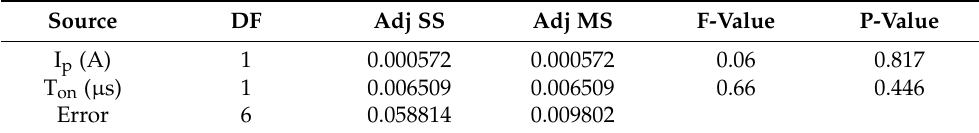
Figure 9. Main effect plot of the MTR. Analysis of variance (ANOVA) was conducted to found the significance of each parameter, and the results for MTR are shown in Table 5. The ANOVA test was carried out at a 5% significant level. It is noticed that pulse-on time has the lower value of p. Table 5. ANOVA analysis for